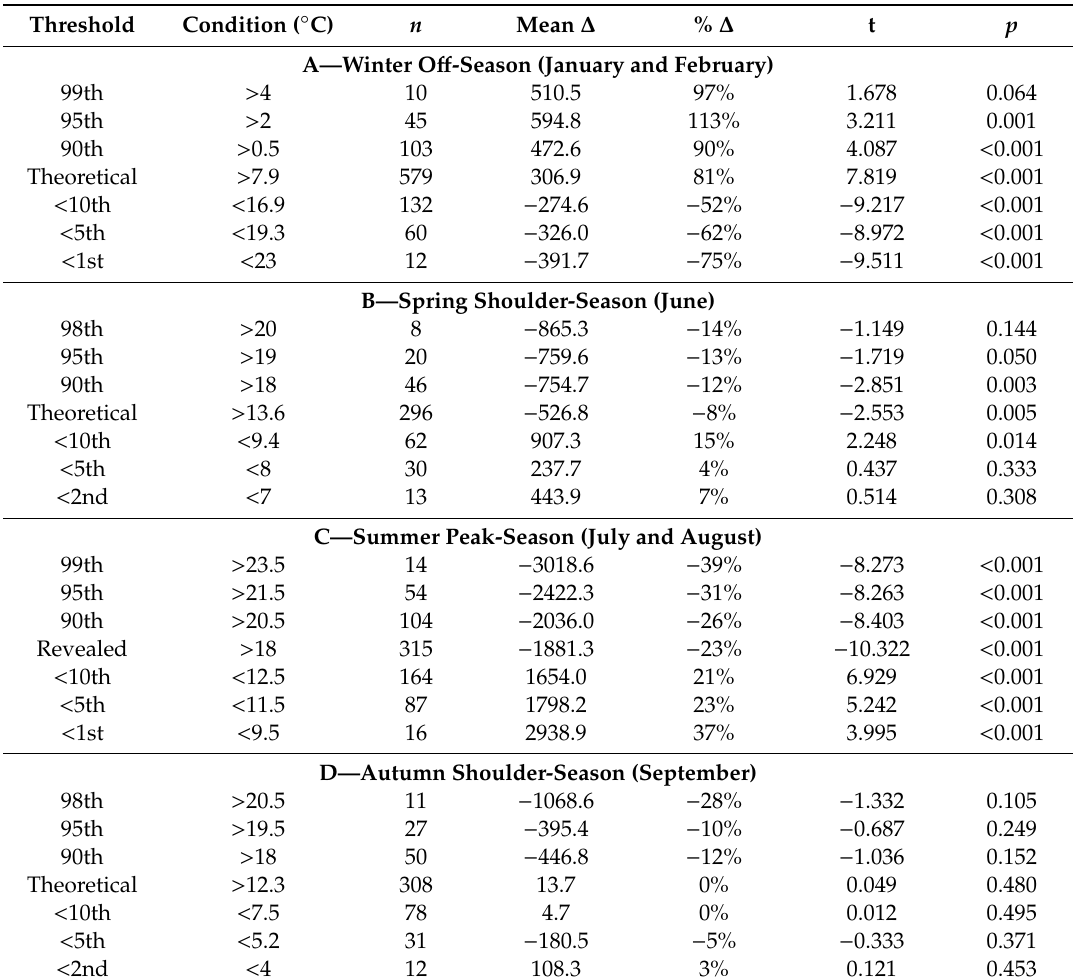
Table 3. The e ff ect of extreme nighttime temperatures on zoo attendance in Toronto, across four di ff erent